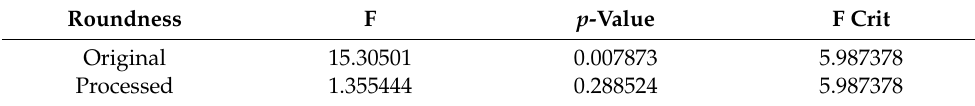
Table 11. One factor ANOVA of roundness of workpiece with the multiple-lobe profile.